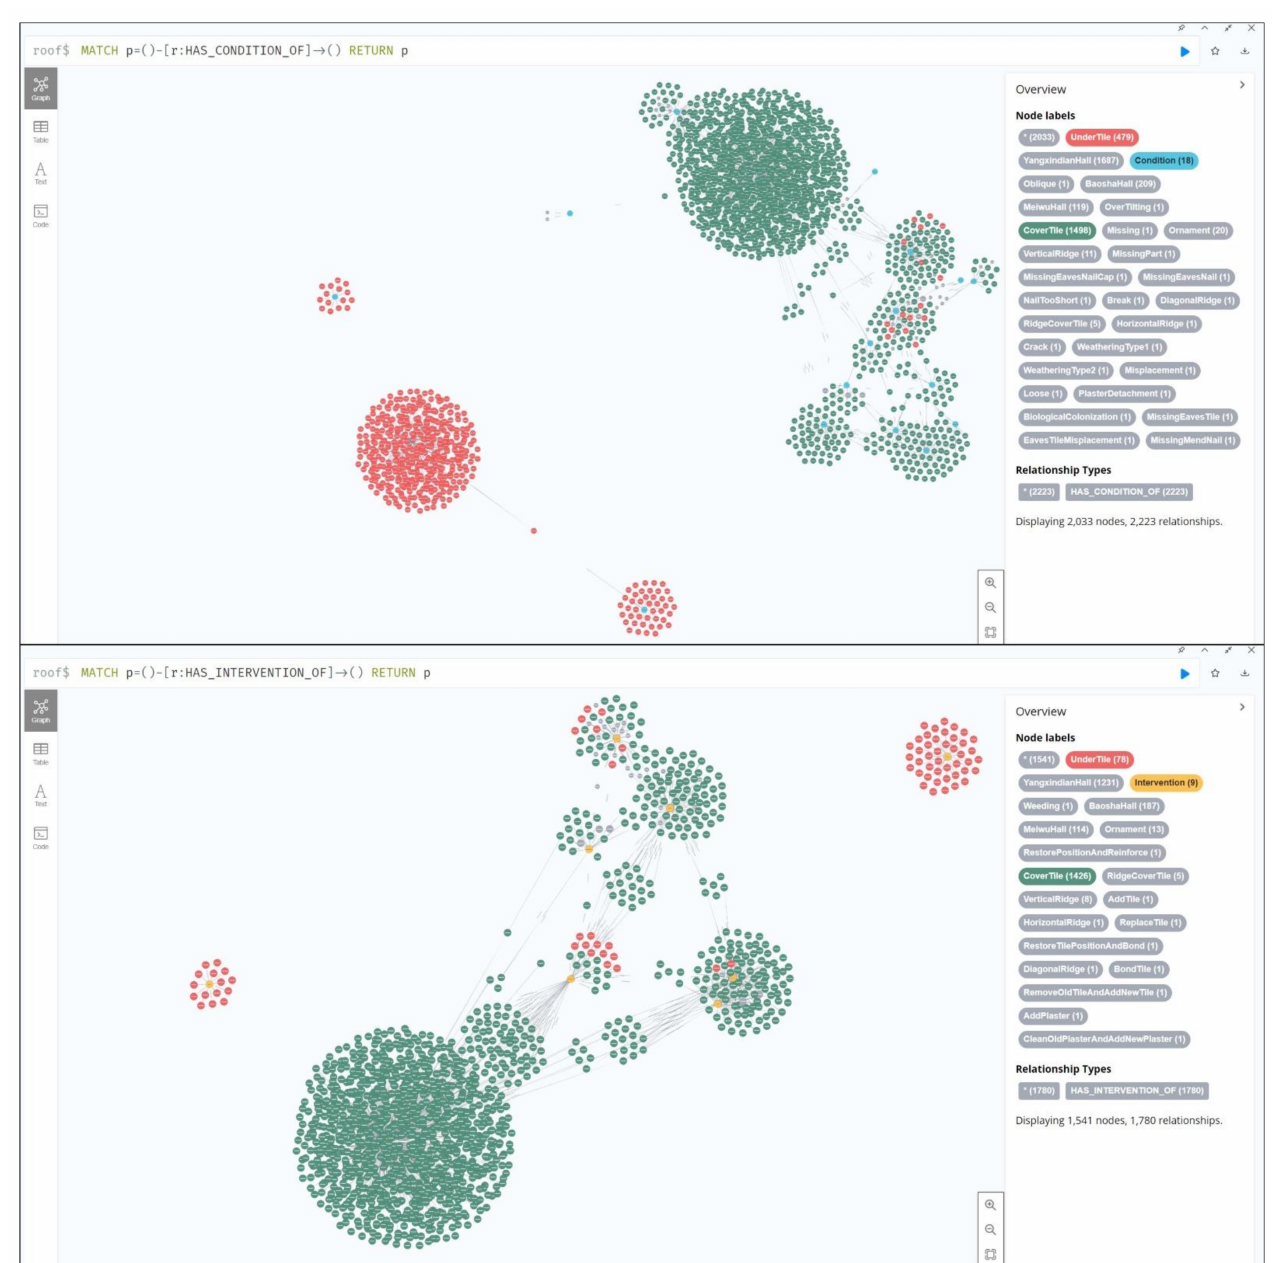
Figure 14. Semantic relationships of conditions and